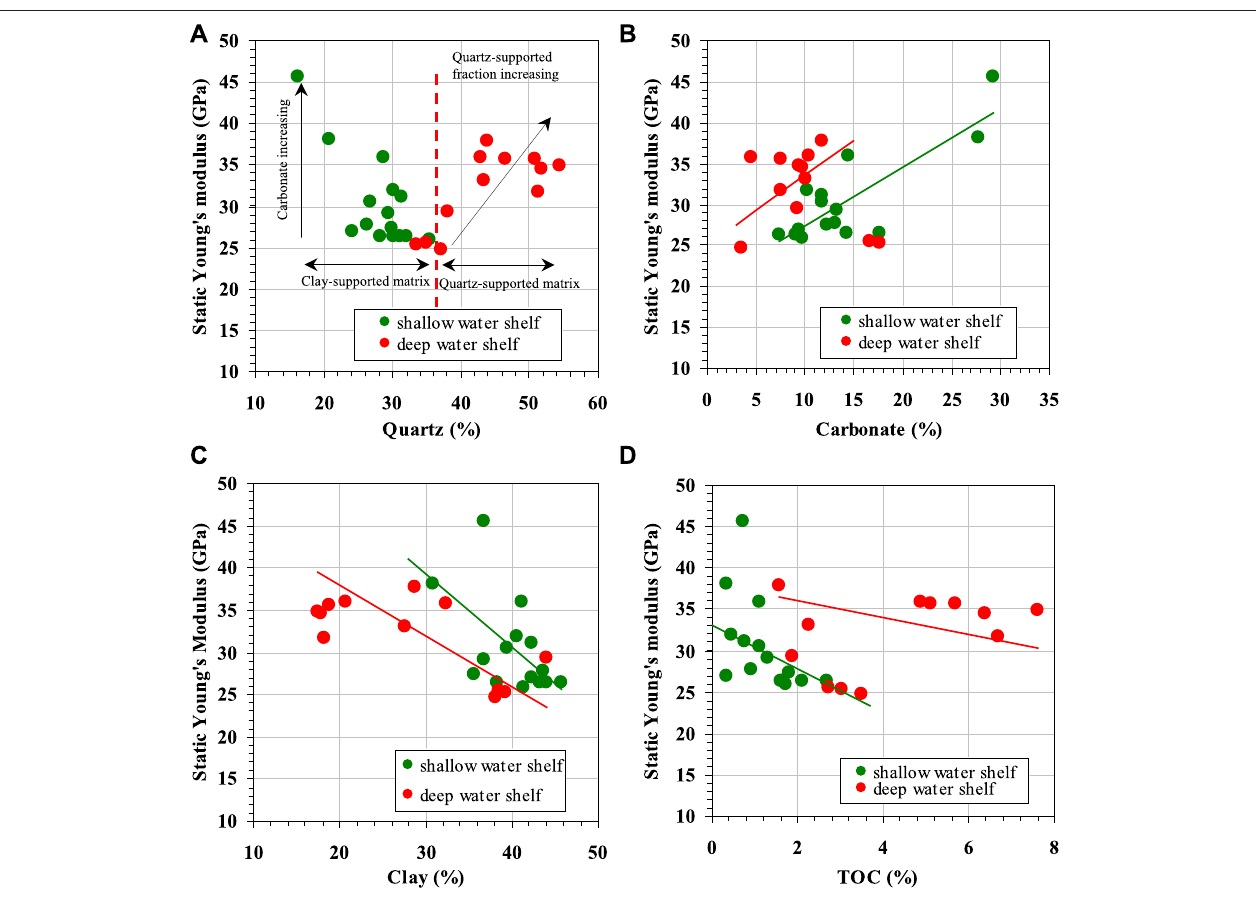
FIGURE 11 | Crossplot of static Young ’ s modulus with major mineral composition. (A) Crossplot between static Young ’ s modulus and quartz content. (B) CrossplotbetweenstaticYoung ’ smodulusandcarbonatecontent. (C) CrossplotbetweenstaticYoung ’ smodulusandcarbonatecontent. (D) Crossplotbetweenstatic Young ’ s modulus and TOC